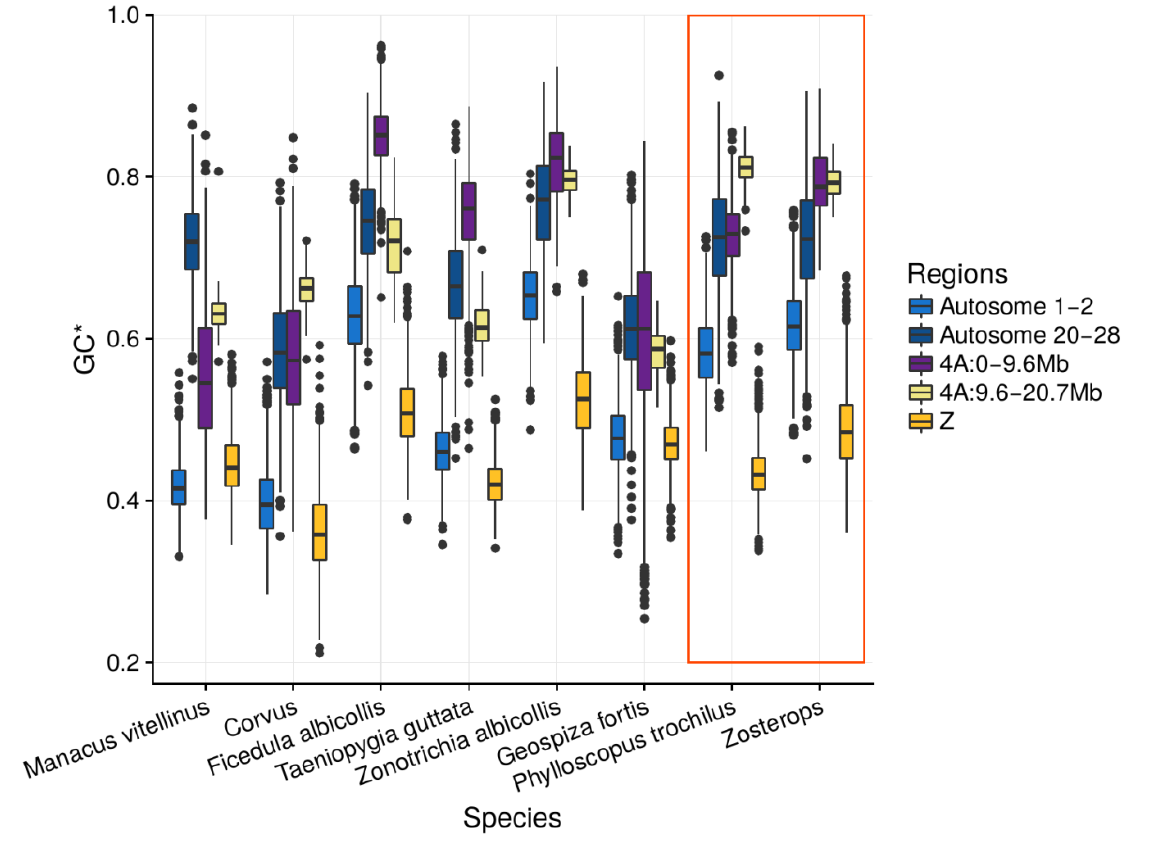
Figure S8. Variations in GC content at equilibrium (GC*) at third codon positions. Variability was obtained by bootstrapping genes within each genomic region.